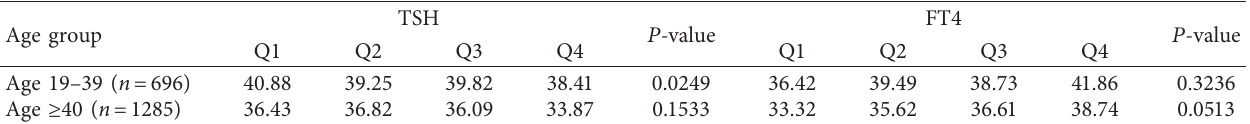
Corrected by sex, smoking, drinking, diabetes, and exercise. BMI, body mass index (calculated as weight divided by height squared (kg/m 2 )). FT4, free thyroxine. TSH, thyrotropin. TSH (mIU/L), Q1 ≤ 1.51, 1.51 < Q2 ≤ 2.21, 2.21 < Q3 ≤ 3.17, 3.17 Q4 ≤ 29.50. FT4 (ng/dL), Q1 ≤ 1.13, 1.13Q2 ≤ 1.23, 1.23 < Q3 ≤ 1.35, 1.35 < Q4 ≤